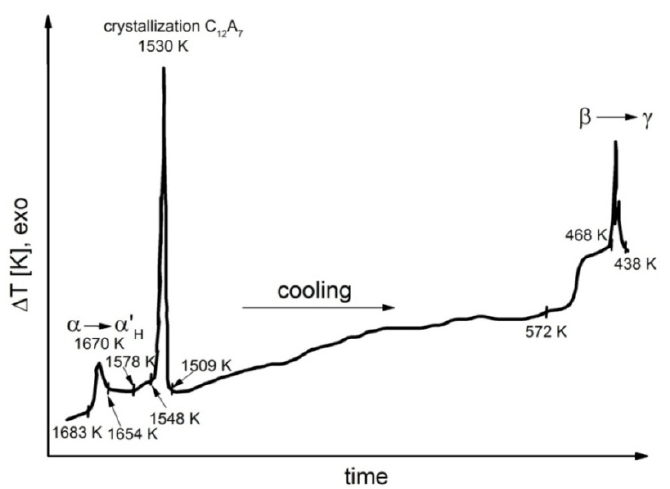
Figure 8. Thermogram recorded for sample 6 during the cooling process.